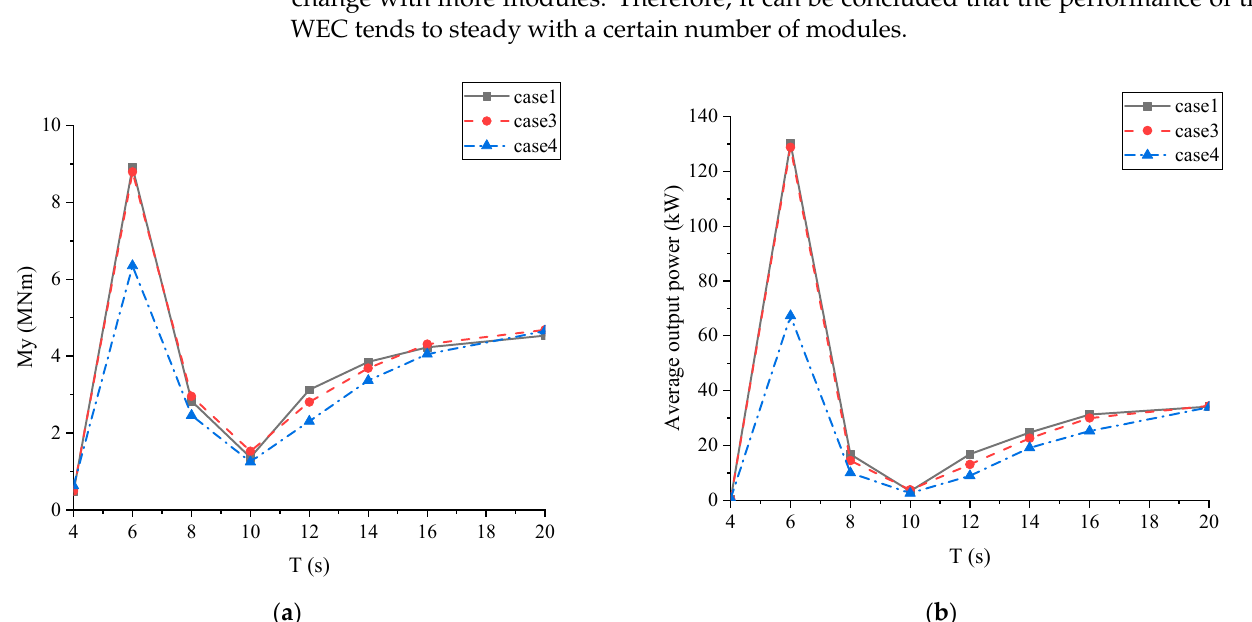
Figure 13. WEC performance in head sea under different layouts: ( a ) pitch bending moment of C1; ( b ) average output power of WEC1.